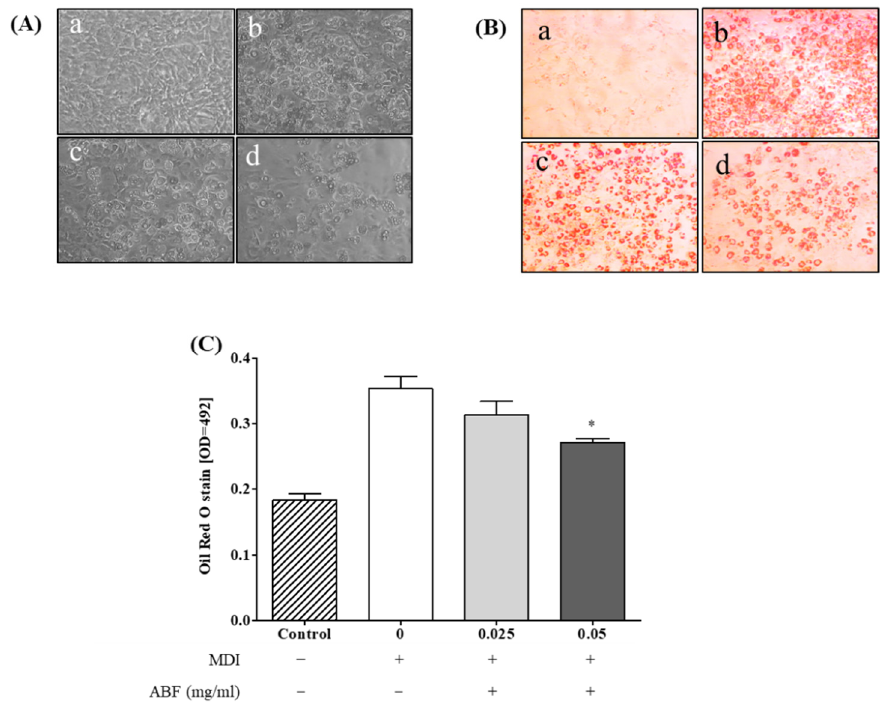
Figure 5. Effects of Aronia bioactive fraction (ABF ® ) on lipid accumulation in 3T3-L1 adipocytes. ( A ) Lipid accumulation in the cells viewed under an inverted microscope (100× magnification) and ( B ) determined by Oil red O staining. ( C ) Lipid accumulation measured after Oil Red O elution. ( a ) 3T3-L1 cells cultured in the non-differentiation medium, ( b ) adipogenic differentiation medium only (MDI control), ( c ) adipogenic differentiation medium + ABF ® 0.025 mg/mL, and ( d ) and adipogenic differentiation medium + ABF ® 0.05 mg/mL. Data represent the mean ± SEM. * p < 0.05 compared with the MDI control group.